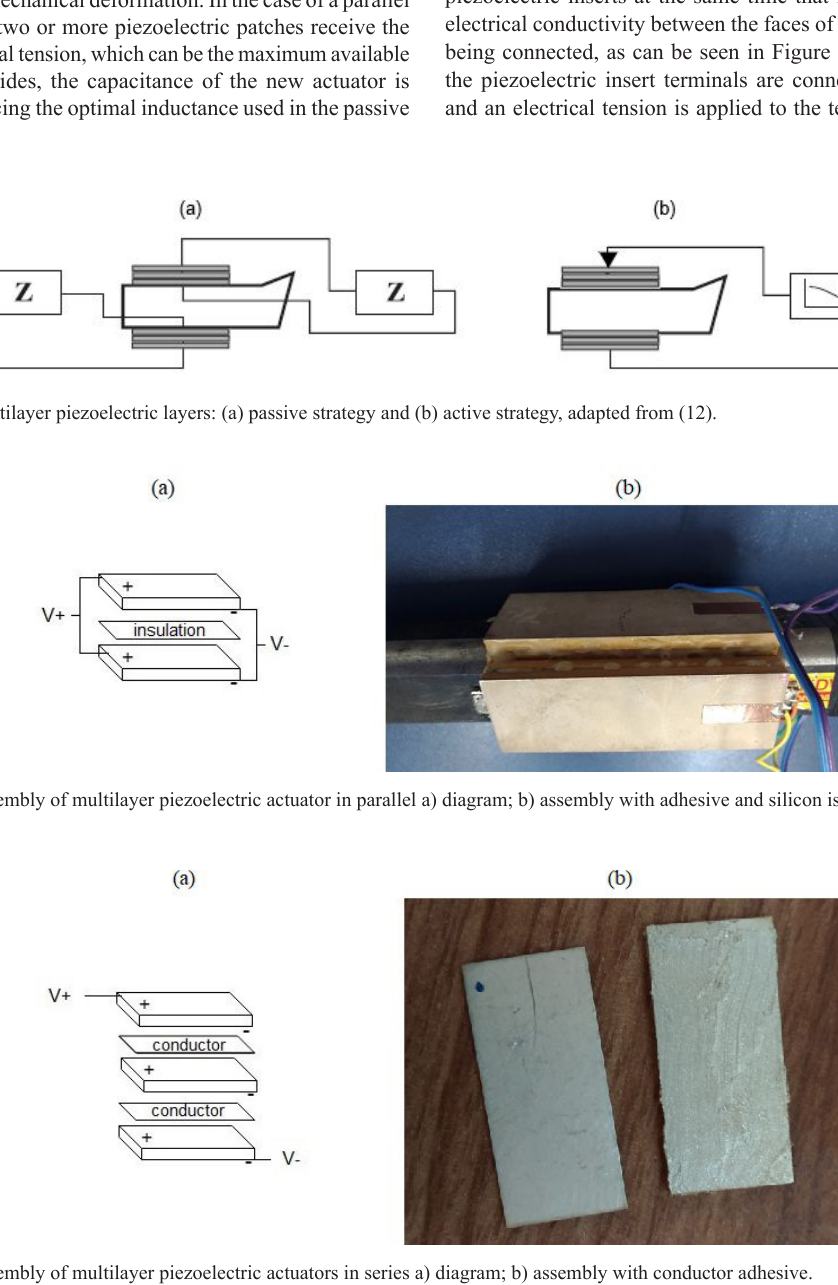
Figure 4. Assembly of multilayer piezoelectric actuators in series a) diagram; b) assembly with conductor